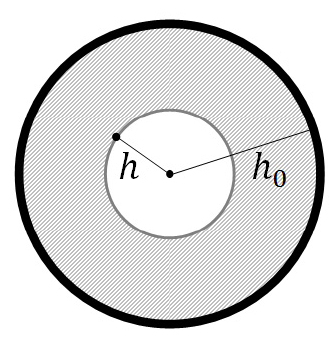
Figure 2. The circular hollow metallic layered